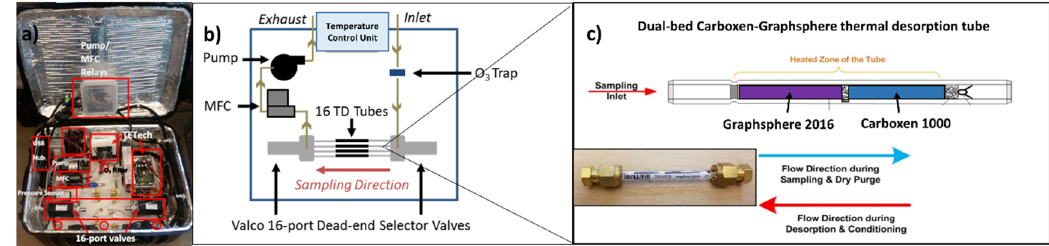
Figure 1. ( a ) Internal view of the volatile organic compound (VOC) suitcase sampler; ( b ) Flow diagram of VOC suitcase sampler; ( c ) Schematic diagram of the dual-bed Carboxen-Graphsphere TD tubes.